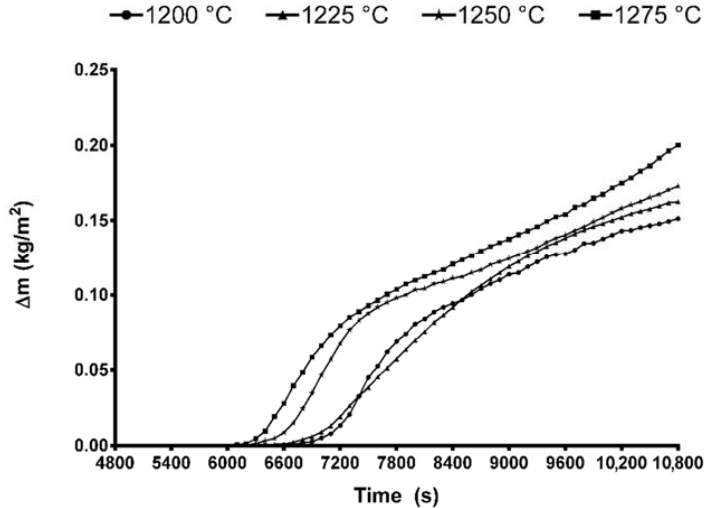
Figure 4. TG results from air atmosphere.